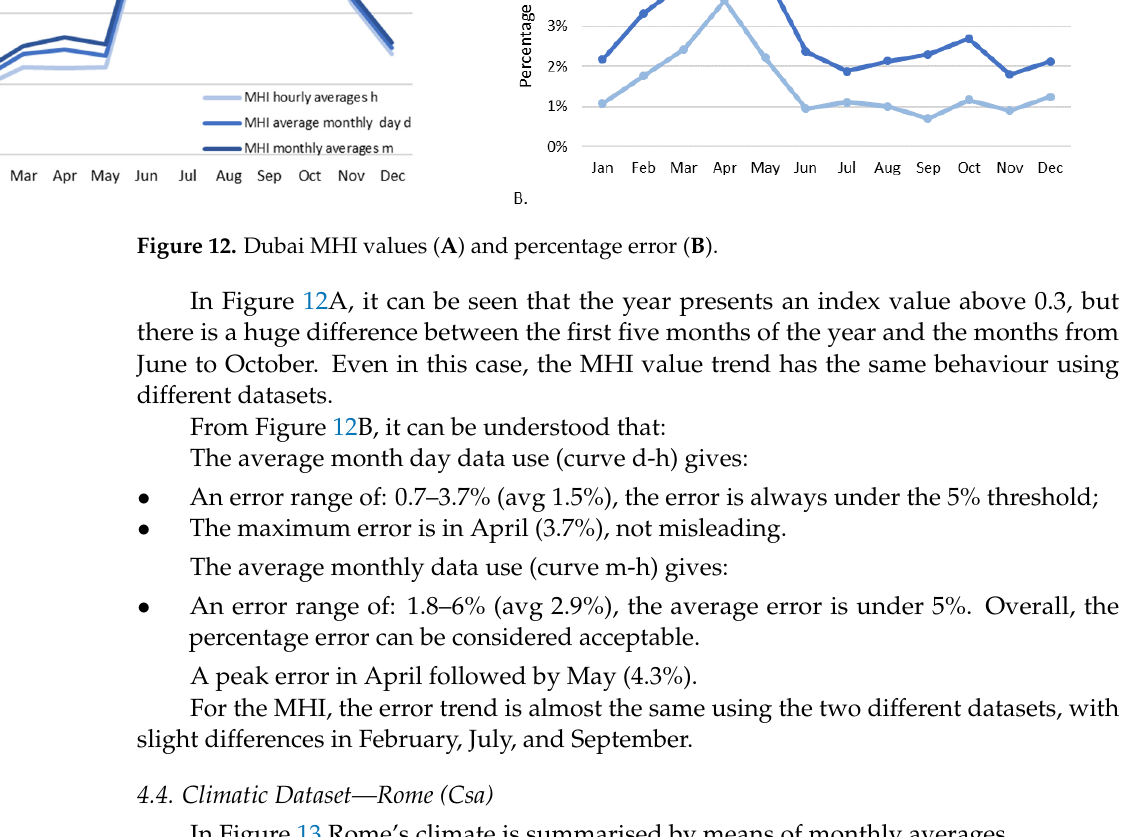
Figure 13. Rome t and r.h. during the average year. It can be observed that: •